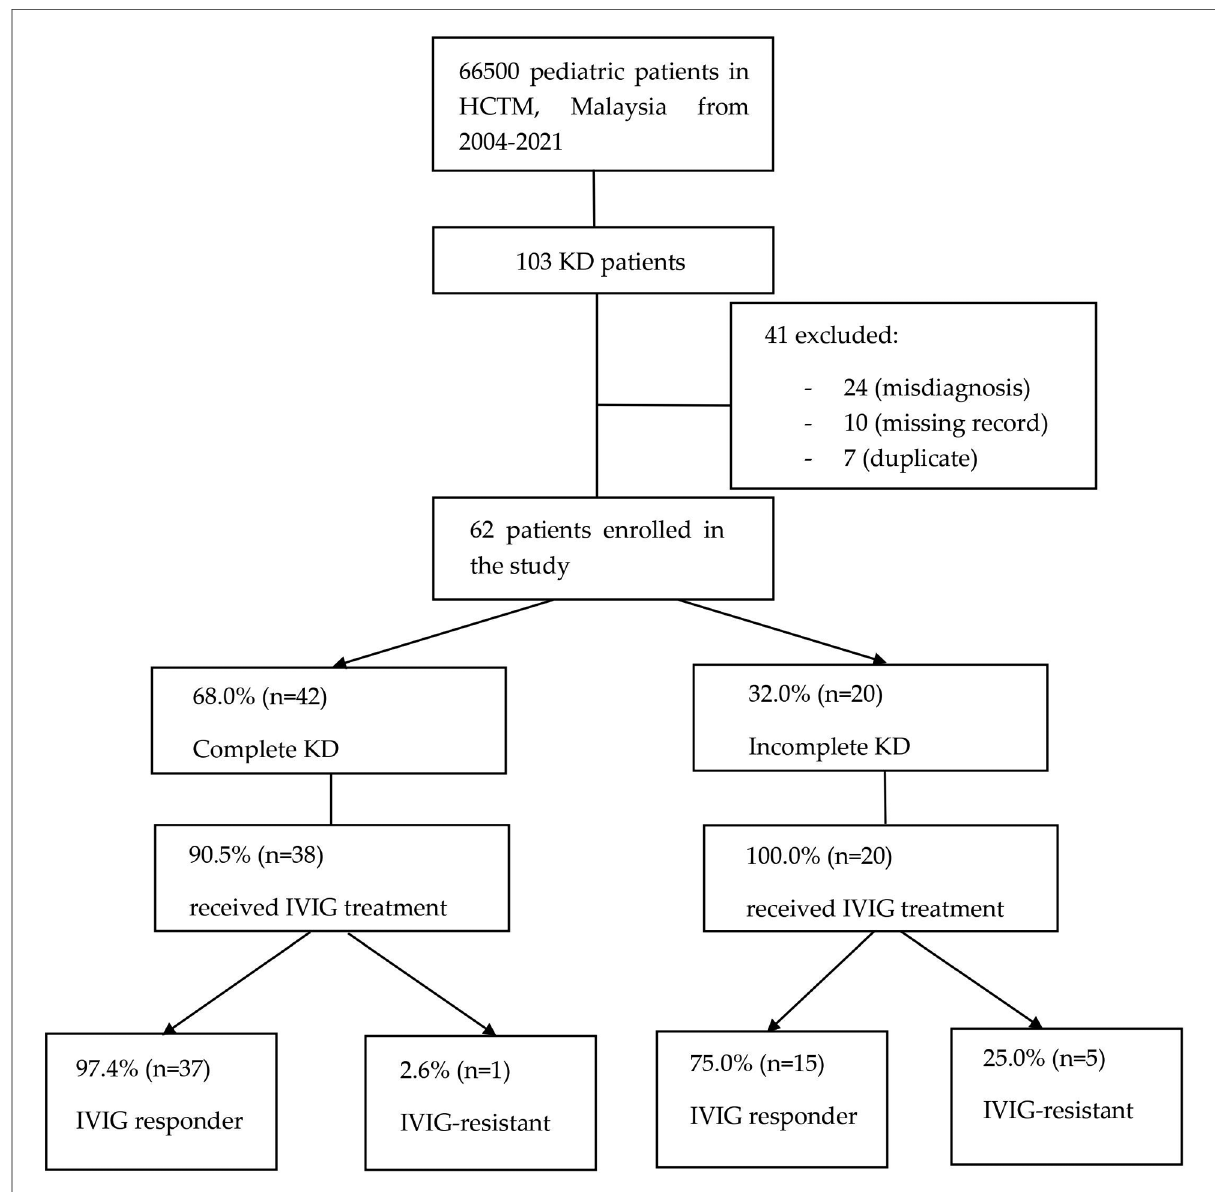
FIGURE 1 Flowchart showing KD patients enrollment and their clinical information. Among 103 KD patients in HCTM from 2004 to 2021, 41 were excluded from this study due to missing record, misdiagnosis, and duplicated record. KD, Kawasaki disease; HCTM, Hospital Canselor Tuanku Muhriz; IVIG, intravenous